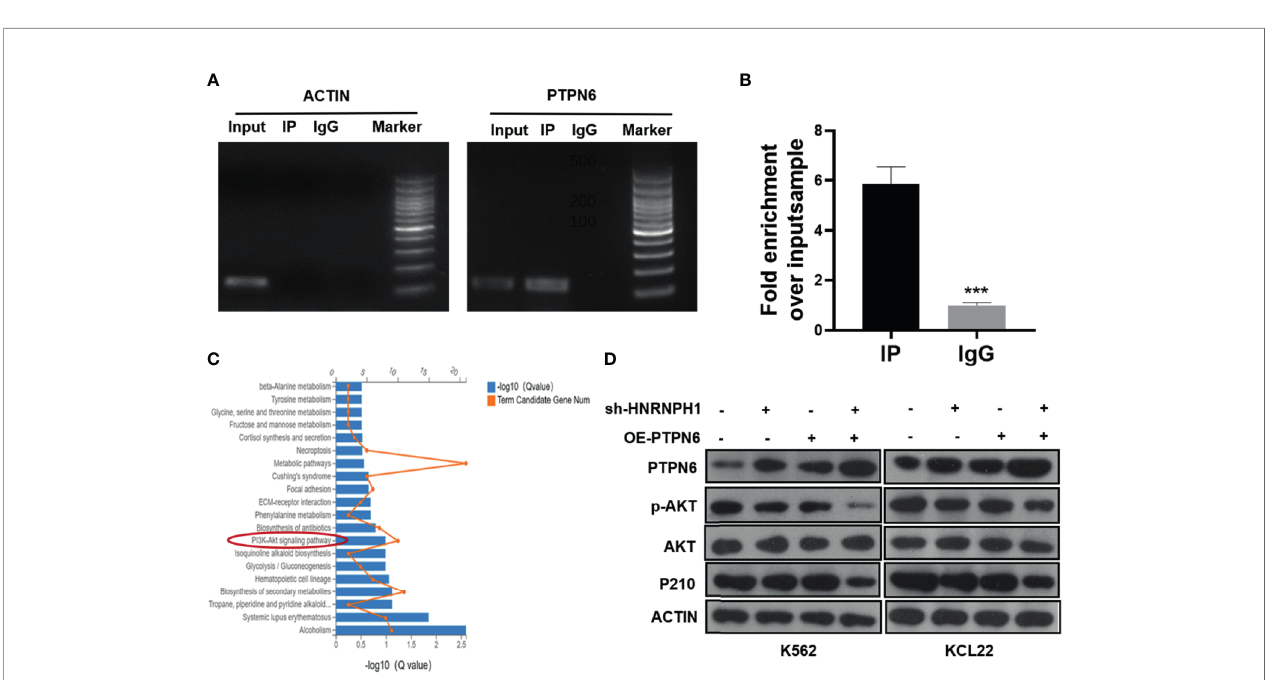
FIGURE 5 | HNRNPH1 regulates PI3K/AKT pathway by binding to PTPN6. (A, B) RIP-PCR and agarose gel electrophoresis were used to test the interaction between the HNRNPH1 protein and PTPN6 mRNA. ***P < 0.001 vs. IgG (C) . KEGG pathway signi fi cant enrichment was used to identify the main biochemical metabolic and signal transduction pathways involved in differentially expressed genes. (D) CML cells were transfected with sh-HNRNPH1 or PTPN6 overexpression plasmid or co-transfected them together. Western blot analysis was used to detect PTPN6, p-AKT, AKT, and P210BCR-ABL protein